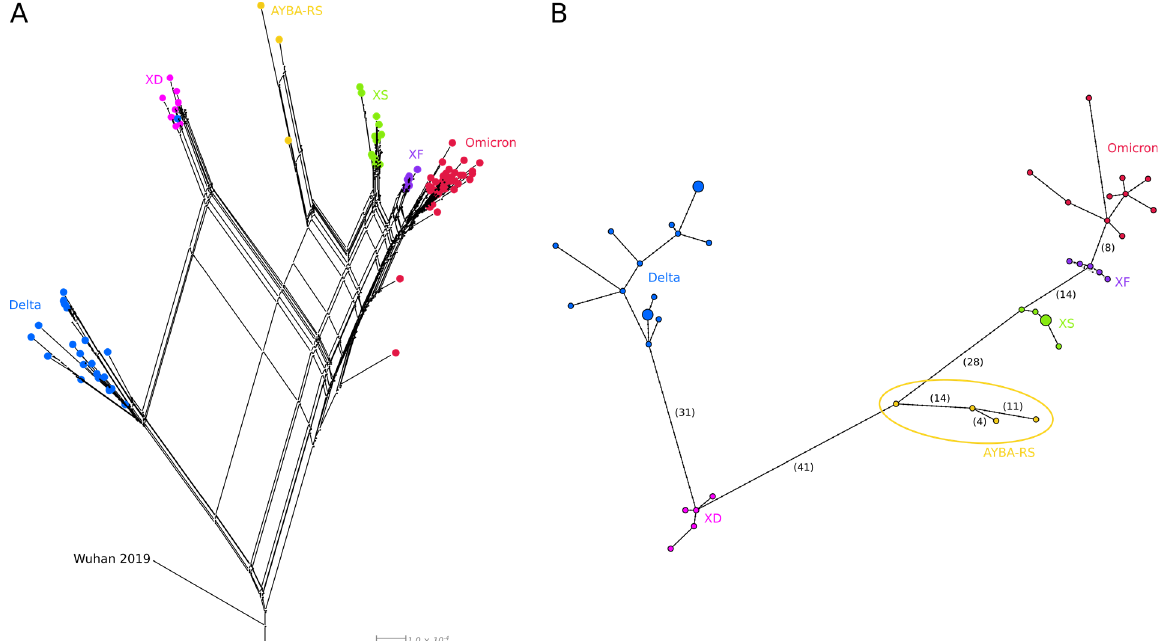
Figure 3. The evolution of Deltacron variants (XD, XF, XS and AYBA-S) in relation to that of their parental variants (Delta and Omicron). ( A )—Phylogenetic network of Deltacron sequences built with SplitsTree (NeighborNet method, RootedEqualAngle on Wuhan/WH01/2019). The loops in this network are consistent with recombinant evolution. ( B )—Haplotype network of Deltacron sequences made with pegas (haploNet method). The number of SNPs is in parentheses (Table A5); the AYBA-RS is within an ellipse. In both analyses, Delta (AY.101, AY.4, B.1.617.2) and Omicron (BA.1, BA.1.1) sequences were used as references. Nodes are coloured according to the variant type.